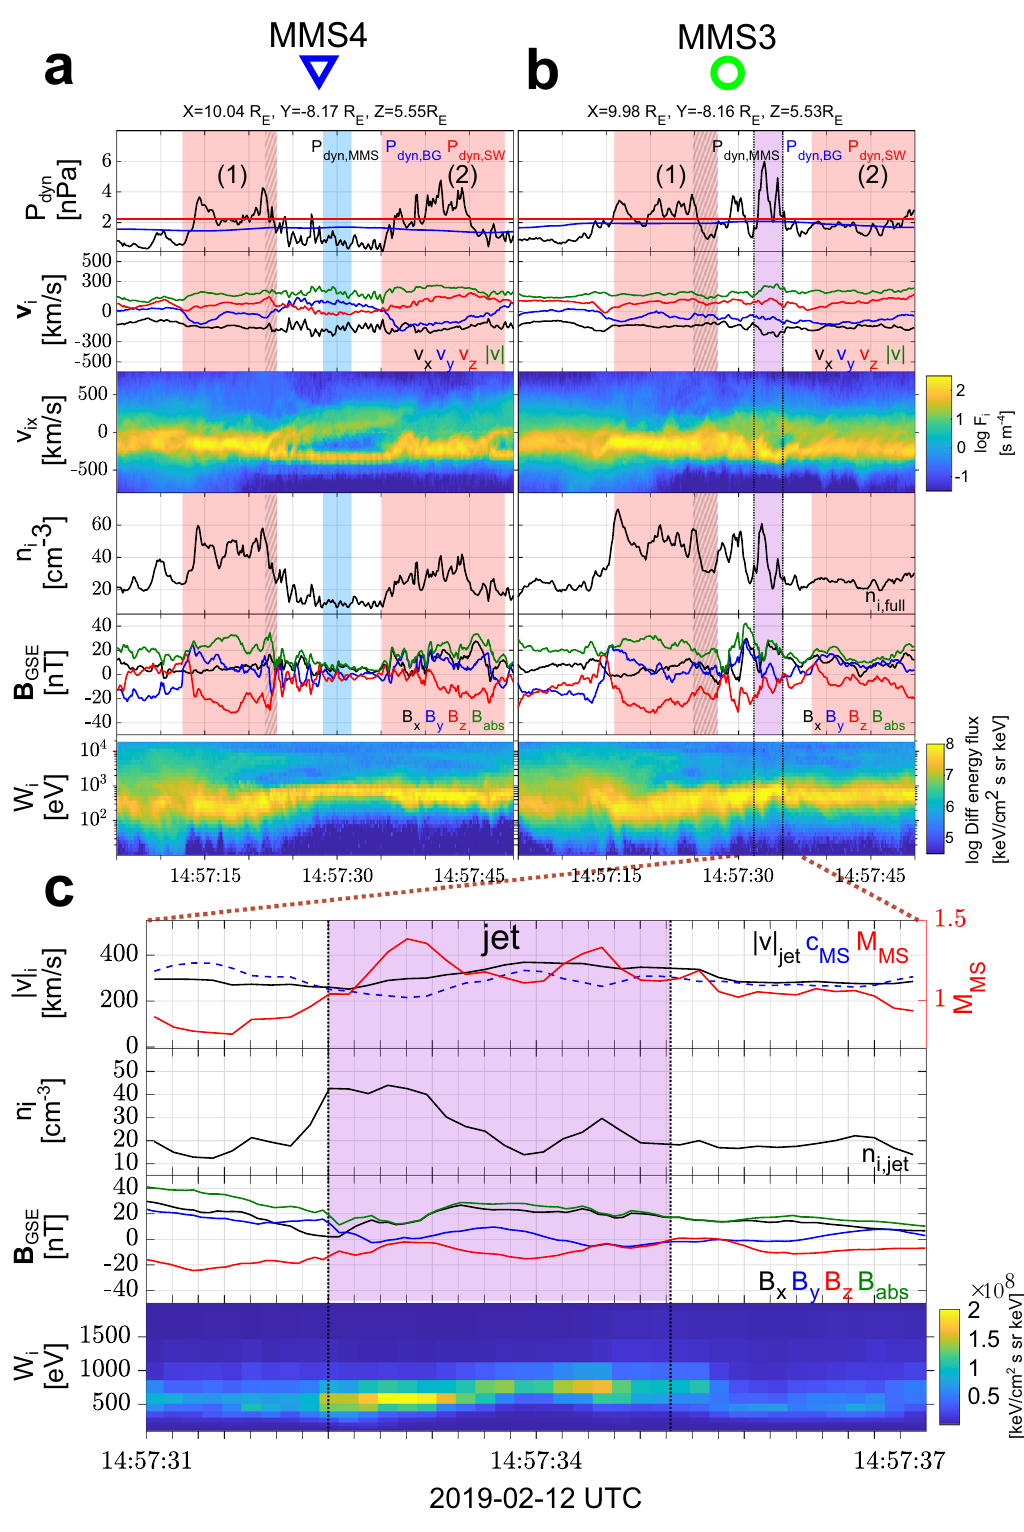
Fig. 6 Zoomed in view of the measurements for Magnetosphere Multiscale (MMS) 4 and 3. a , b Detailed observations of the innermost MMS spacecraft 4 and 3, ordered by furthest to closest to the Earth. (Top-bottom): ion dynamic pressure along with solar wind and magnetosheath background level, ion velocity, reduced 1D Velocity Distribution Function (VDF) in the x- direction, ion number density, magnetic fi eld measurements, and differential energy spectrum. Special indication has been made regarding the compressive magnetic structures (red regions 1 and 2), the pile-up region (patterned red region), the jet observation (purple), and the corresponding upstream waves (blue region). Shaded region are approximated using the methodology illustrated in Fig. 7 and discussed in the methods subsection Cross-correlation and timing. c Shows the partial moments (see “ Methods ” subsections Jet de fi nition and MVA and distribution functions.) for the jet observed by MMS3. From top to bottom, jet ’ s bulk velocity, along with fast magnetosonic speed and fast magnetosonic Mach number, ion number density, magnetic fi eld components, and differential ion energy